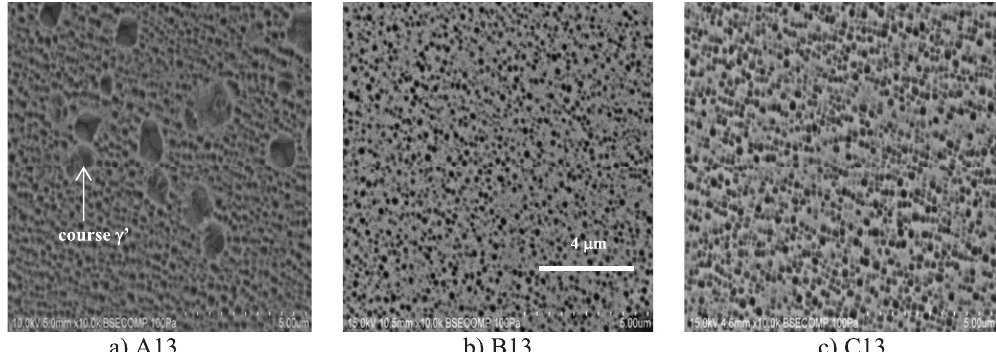
Figure 18. Microstructures of specimens after reheat treatment of Program 6.